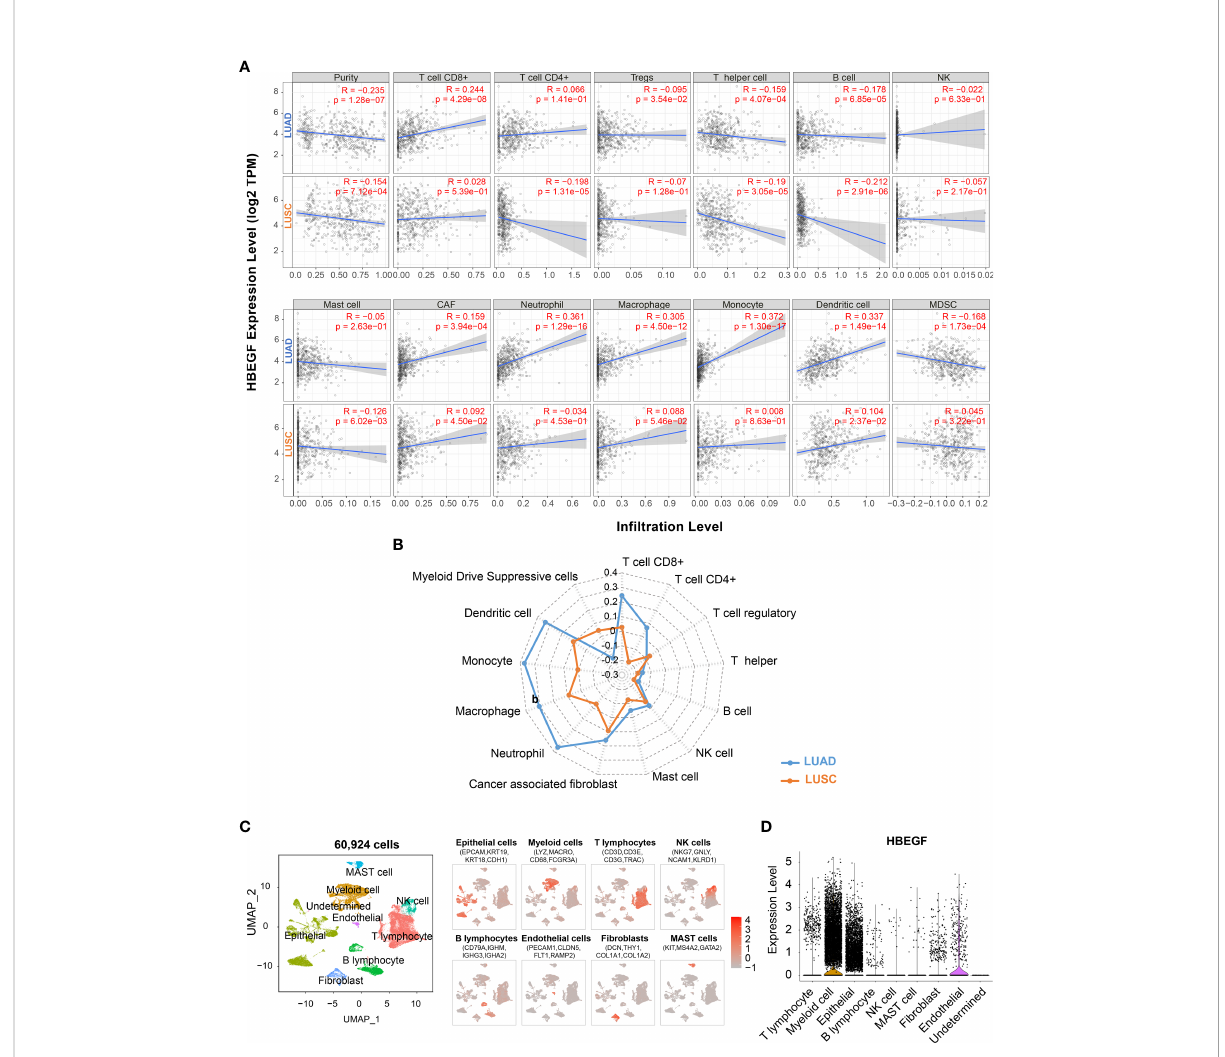
FIGURE 3 Correlation of the HB-EGF expression level with immune in fi ltration cells: (A, B) Spearman ’ s correlation between HB-EGF and immune in fi ltration cells in LUAD and LUSC using TIMER2. (C) UMAP plot of 60,924 cells in 15 LUAD tumor samples using single-cell RNA-seq data GSE131907, colored by eight types of major cell lineages including epithelial cells, myeloid cells, T lymphocytes, natural killer cell, B lymphocytes, endothelial cells, fi broblast, and mast cells. (D) The violin plot indicated HB-EGF expression across cell types in fi gure (C)